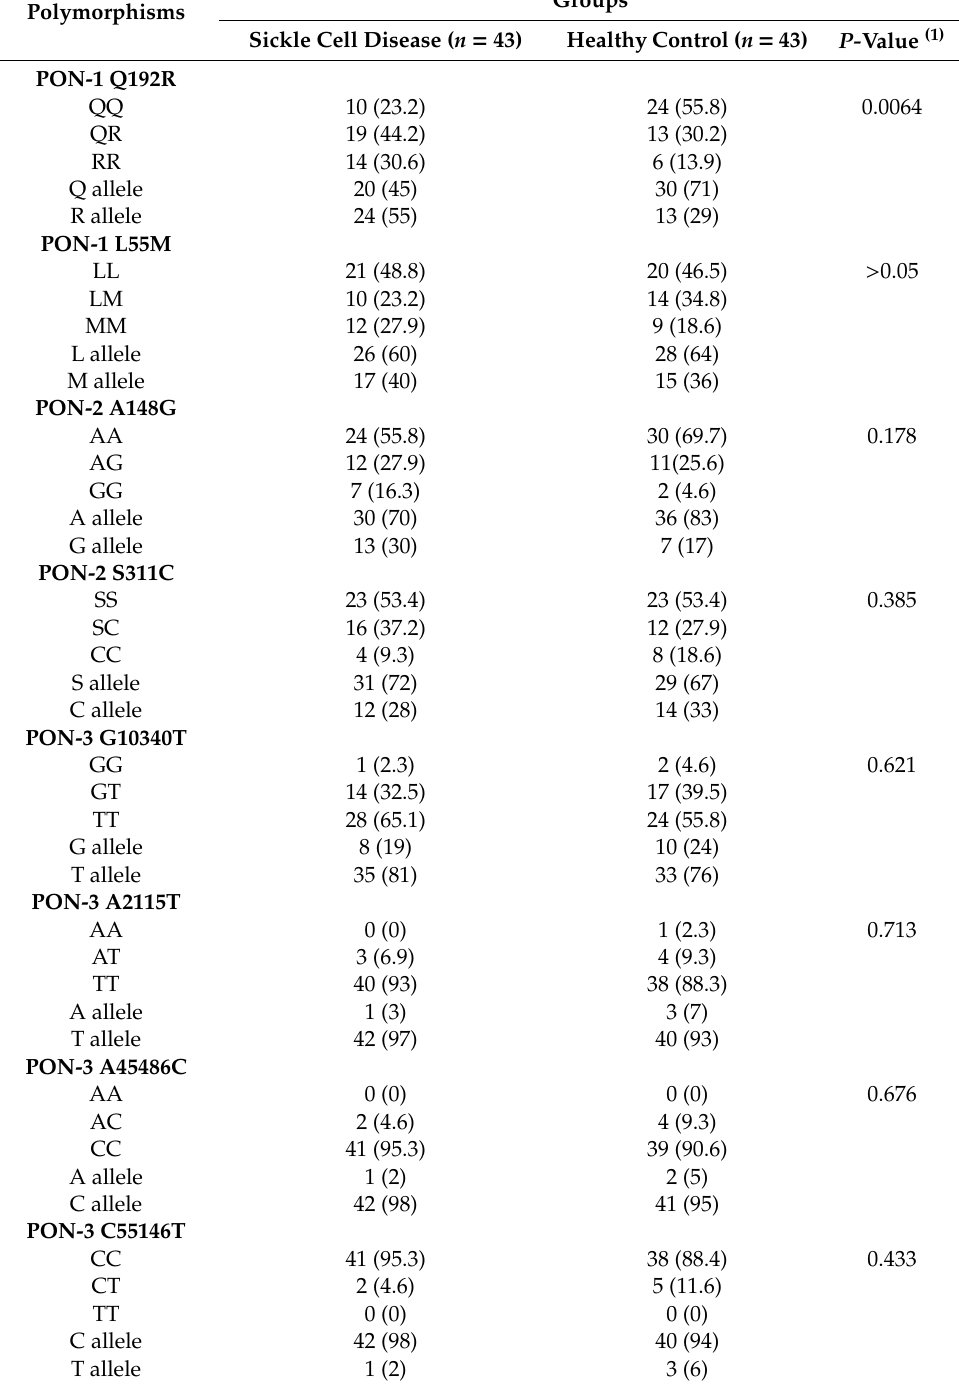
Table 5. Distribution of genotypes and allelic frequency of PON-1 192QR and 55LM polymorphisms, PON-2 148AG and 311SC polymorphisms, and PON-3 10340GT, 2115AT, 45486AC, and 55146CT polymorphisms in patients with sickle cell disease and healthy